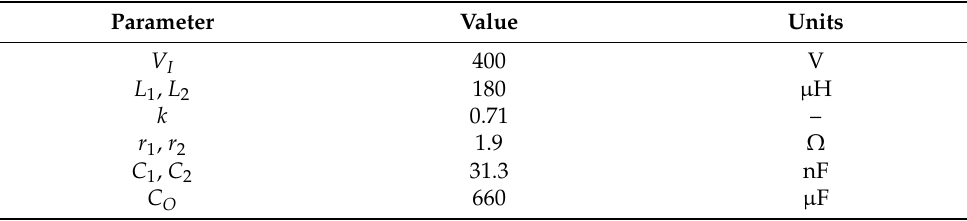
Table 1. System parameter